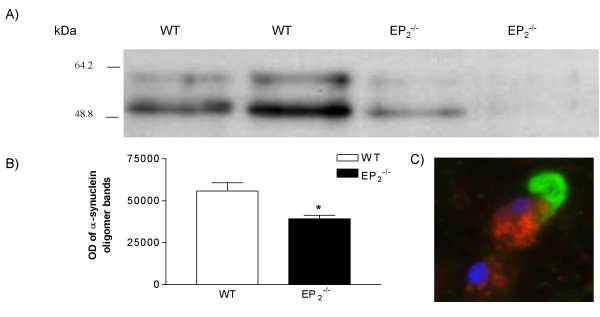
Lack of EP2 enhanced microglial clearance of α-synuclein aggregates. A and B). Tissue sections obtained from patients with dementia with Lewy body disease were incubated with WT and EP2-/- microglia for 48 hrs. Residual α-synuclein aggregates were determined by Western blotting (two bands corresponding to dimers and trimers of α-synuclein). *: p < 0.05 for amount of residual synuclein aggregates in tissue sections treated with EP2-/- vs. WT microglia. C) Tissue sections were stained with CD11b antibody 48 hrs after incubation with microglia. The image demonstrates an activated microglial cell in ex vivo-cultured slides in close proximity to aggregated α-synuclein. Red, CD11b for microglia showing a macrophage-like microglia; green, antibody against human α-synuclein, demonstrating α-synuclein aggregates; and blue, DAPI nuclear staining).